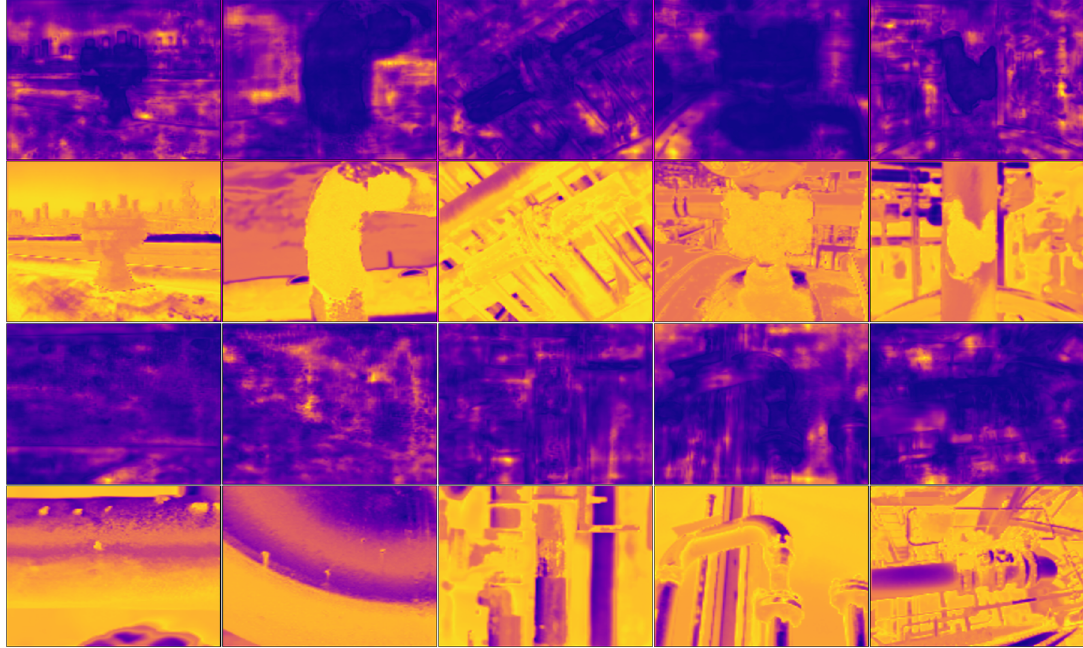
Fig. 11 Ensemble model uncertainty maps. The epistemic ( fi rst and third row) and aleatoric (second and fourth row) uncertainty maps produced by the ensemble model for the example input images (Fig. 5). Colour scale from low = purple to high = yellow.